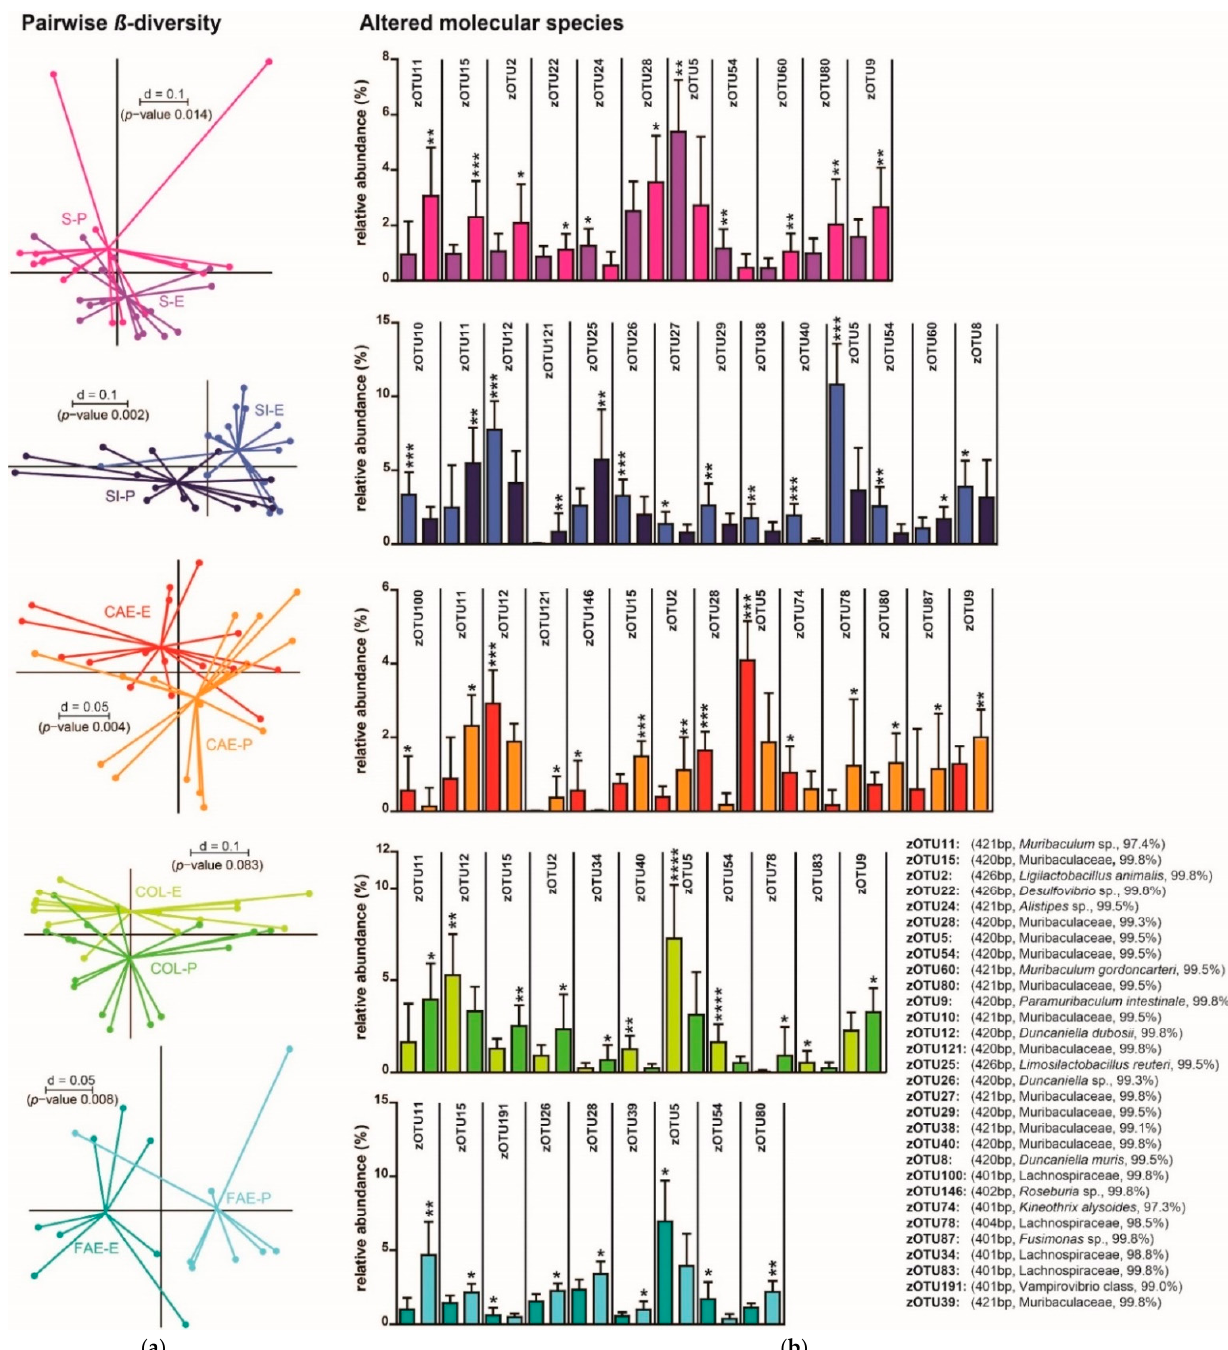
Figure 6. ( a ) Pairwise comparison of β -diversities of trial 2 shown as the multidimensional-scaling plot. Sample origins are indicated by abbreviations. ( b ) Altered molecular species for the respective sample origin, classification and coloring of groups according to ( a ). Stars indicate significance between the respective gut regions of both groups. zOTUs were identified by EZBiocloud; the sequence length, the closest relative taxon and the sequence identity score of zOTUs are indicated in the order of appearance. E = extruded diet, P = pelleted diet, S = stomach, SI = small intestine, CAE = cecum, COL = colon, FAE = feces. p -value summary: * p ≤ 0.05, ** p ≤ 0.01, *** p ≤ 0.001, **** p ≤